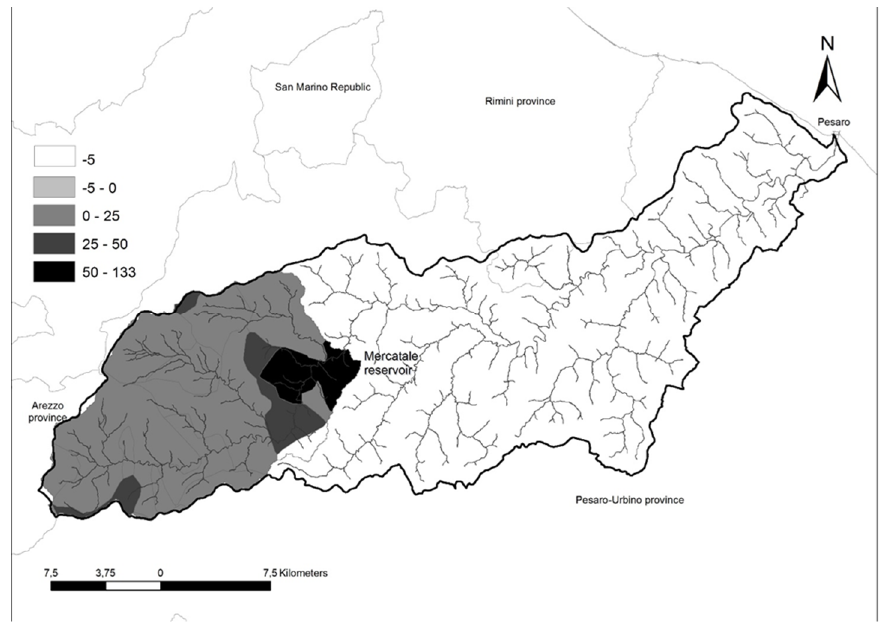
Figure 4. Spatial distribution of N surplus. Units are kg Nha −1 /year.